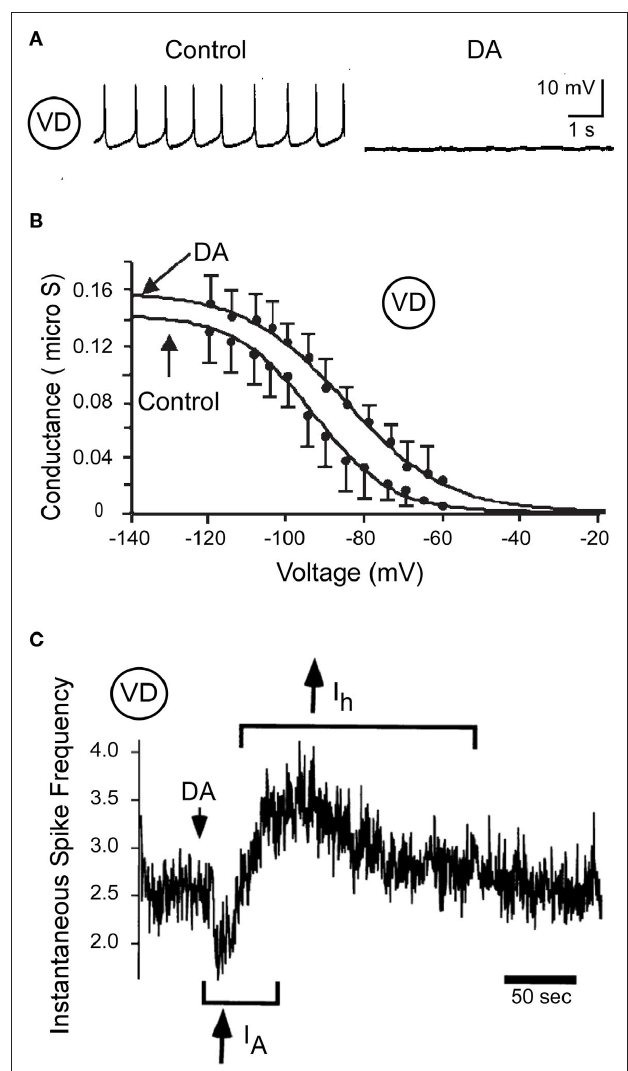
Figure 2 | Dopamine (10 − 4 M) modulates VD neuron excitability. (A) Direct DA inhibition of a synaptically isolated VD neuron (modified from Flamm and Harris-Warrick, 1986b). (B) Effects of DA on I neuron (modified from Peck et al., 2006). (C) Biphasic effect of DA on VD spike frequency; the initial spike frequency reduction is blocked by 4 mM 4-AP ( I and the delayed enhancement of spike frequency is blocked by 5 mM CsCl ( I (modified from Harris-Warrick et al.,